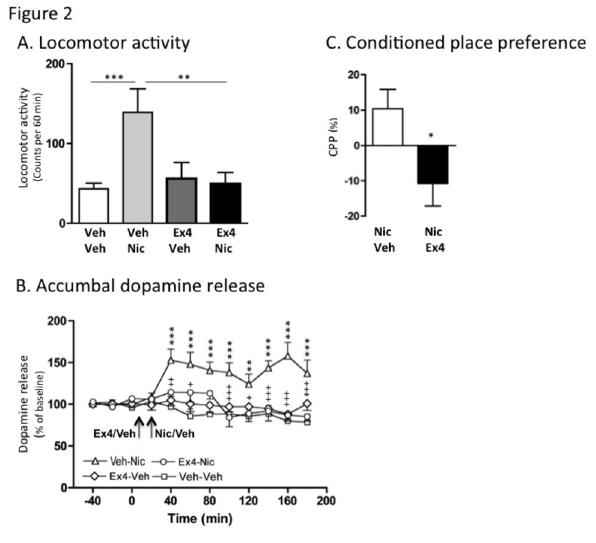
2. Exendin-4 attenuates